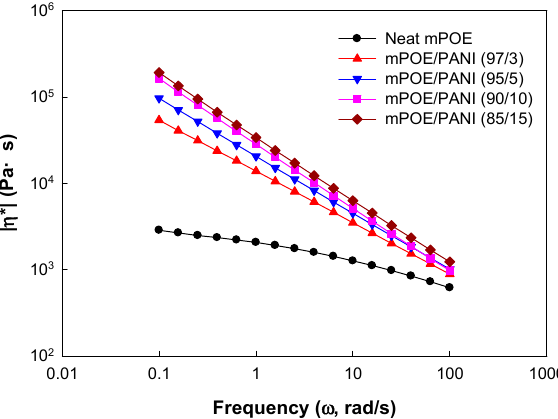
Figure 5. Variation in complex viscosity of mPOE/PANI blends with frequency.